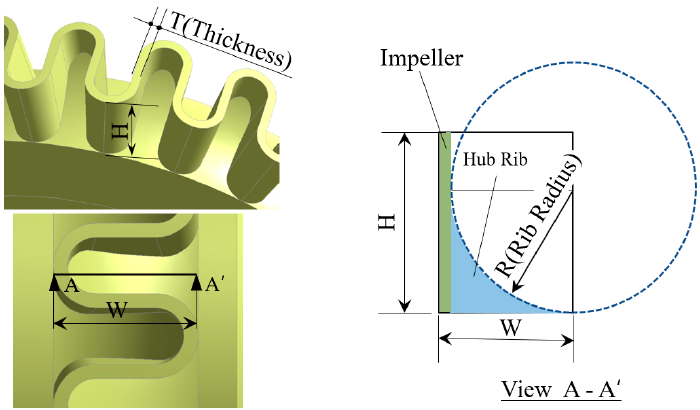
Figure 4. Definition of design variables.